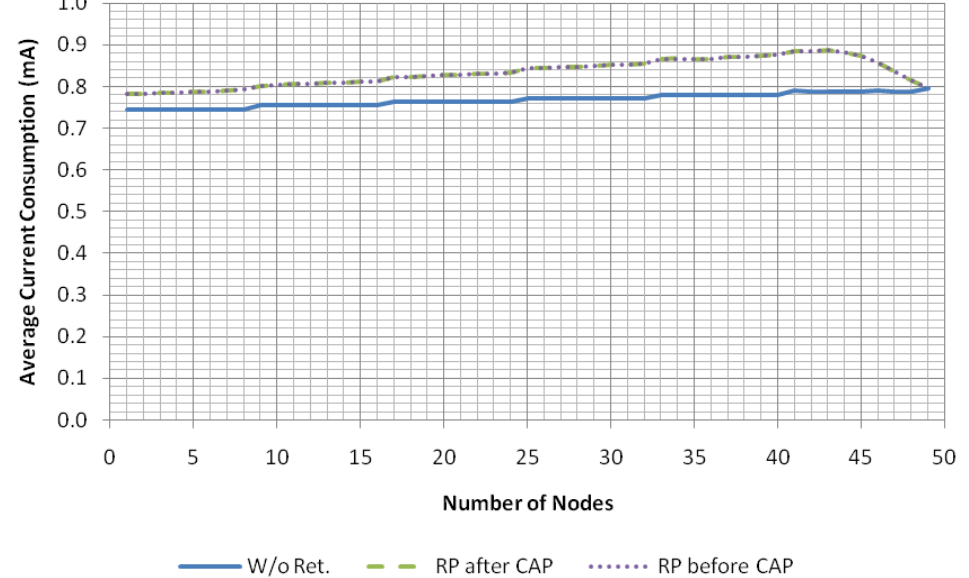
= 10 −2 (data) and 10 −4 bad